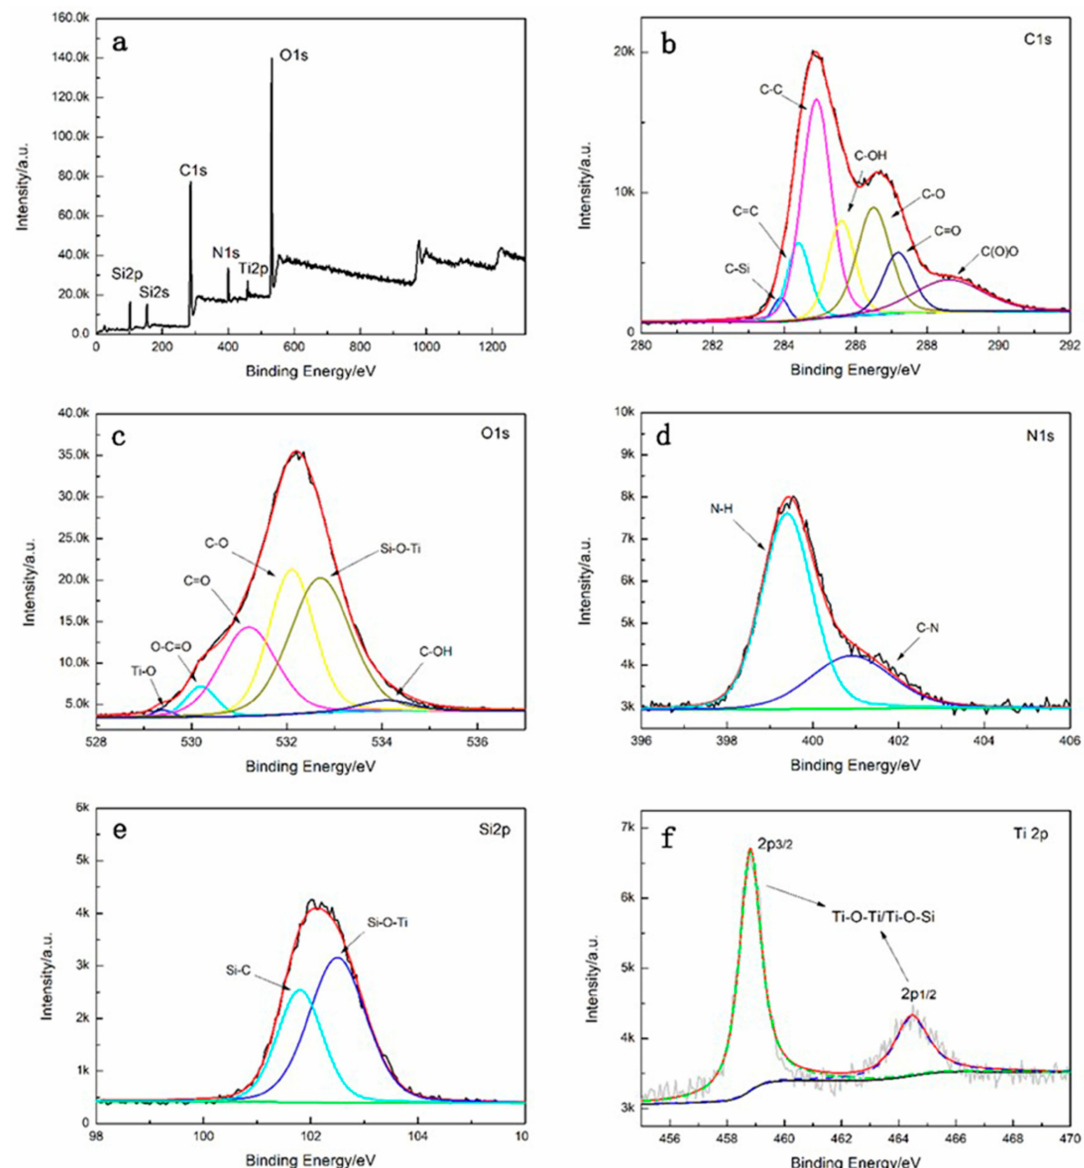
Figure 4. XPS survey spectra ( a ) and high resolution of spectra of ( b ) C1s, ( c ) O1s, ( d ) N1s, ( e ) Si2p, and ( f ) Ti2p of TiO 2